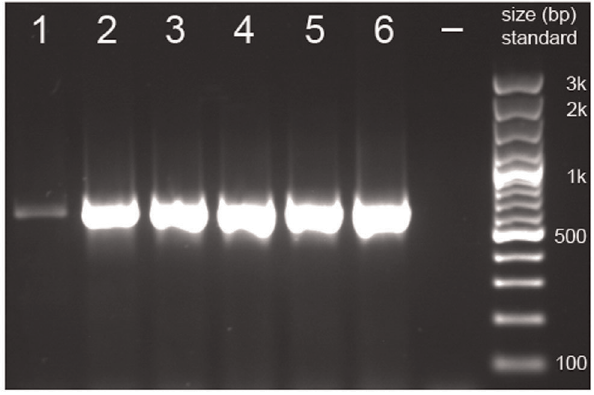
Figure 2. Polymerase chain reaction (PCR) products separated on 1.5% agarose gel. The depicted gel shows the PCR products obtained from using the inferred oligonucleotide primer pair 7229_02_A (Table 3) to PCR amplify DNA of Stephanus serrator (Stephanidae, 1), Leucospis dorsigera (Leucospidae, 2), Gasteruption tournieri (Gasteruptiidae, 3), Chrysis mediata (Chrysididae, 4), Lestica alata (Crabronidae, 5), and Episyron albonotatum (Pompilidae, 6). All PCR products were suitable for direct sequencing with the sequencing oligonucleotide primers HOG-Seq-A-F/ 2 R (Table 2). – = negative control.